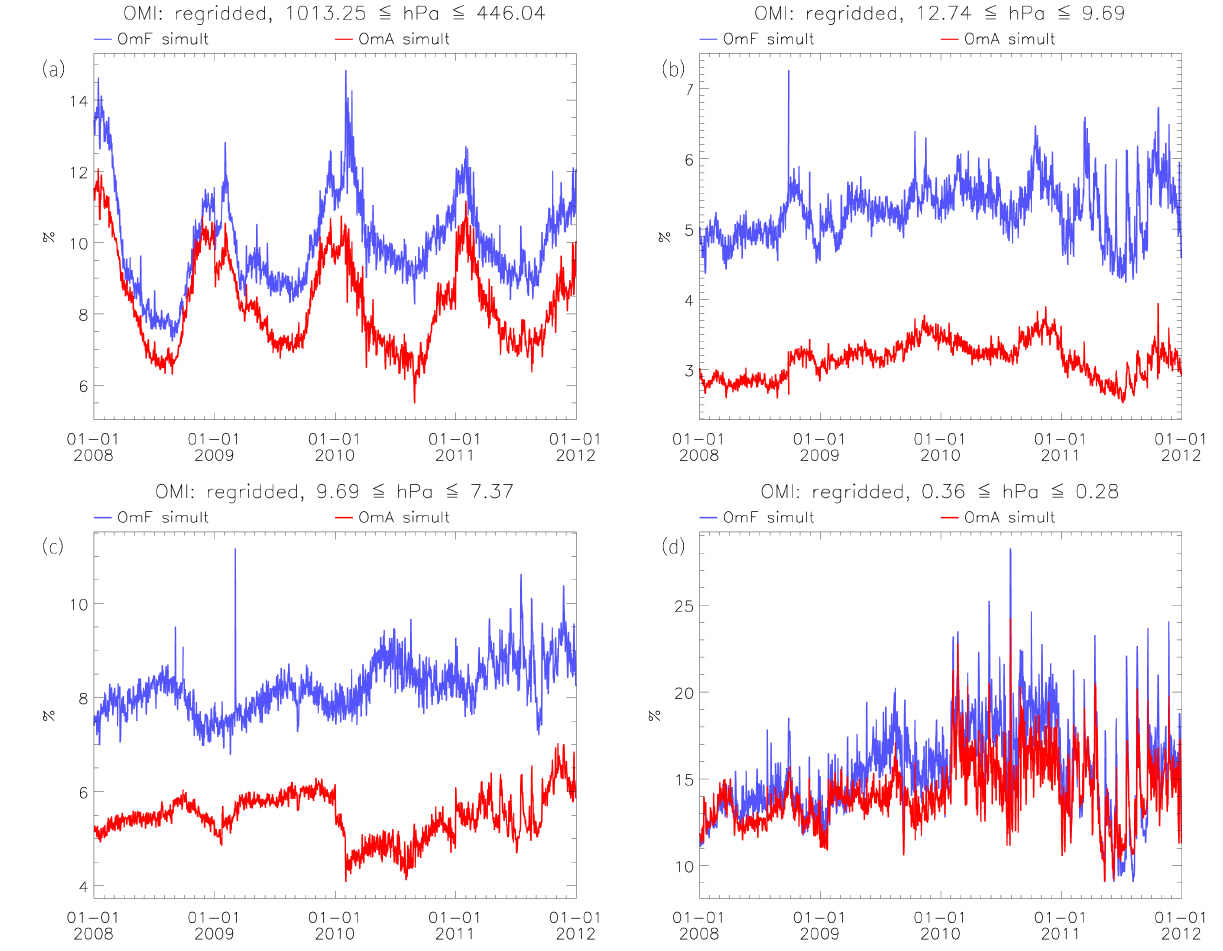
Figure 8. OMI OmF (blue) and OmA (red) for the surface layer (a) , around 10hPa ( b and c ) and around 0.3hPa (d) . The OmF and OmA have been calculated for the regridded layers from the model run with simultaneous assimilation of GOME-2 and